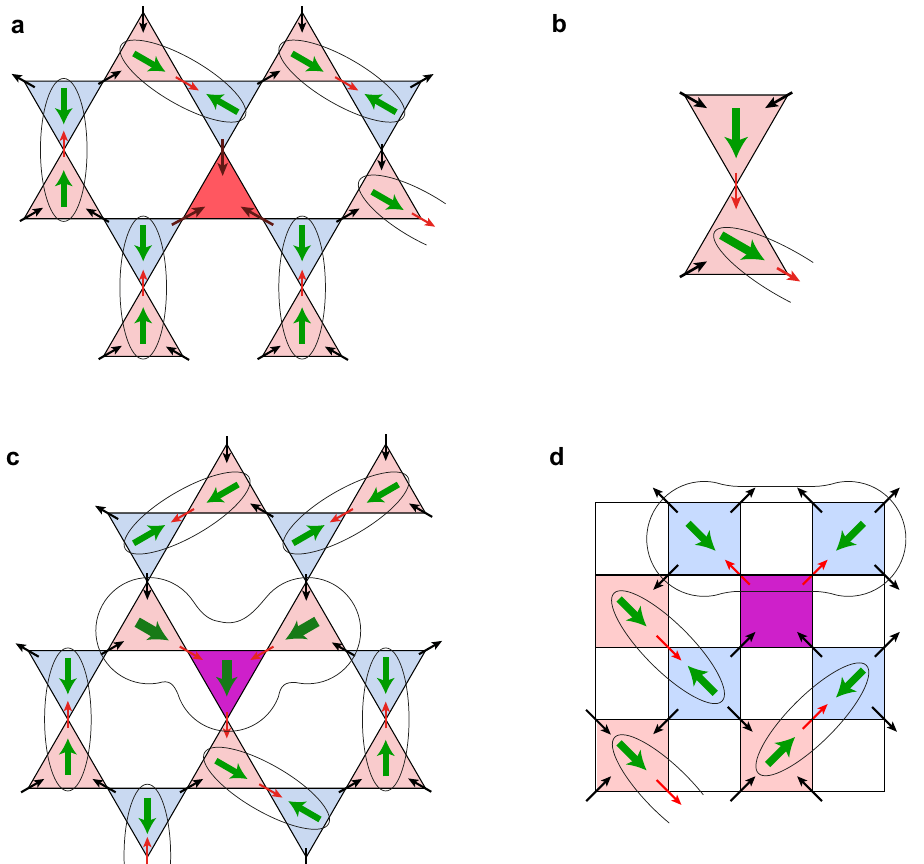
Fig. 3 Dipole structure at defects and monopole textures in kagome moment fragmentation state. a Triangle with (3-in) state ( ‘ tri-pole ’ ). Reconnection of free spins allows to create such defect without free dipoles. b Typical situation with the monopole at the ‘ wrong ’ place, at the antimonopole sublattice, demonstrating the appearance of unpaired dipoles. Note that the common spin is the ‘ normal ’ in-spin for one triangle, but it is a ‘ special ’ out-spin for the other triangle. Consequently the dipole moment at the second, upper triangle would point to this ‘ special ’ spin and would be de fi nitely unpaired. c Monopole in place of an antimonopole (magenta triangle). One sees that it inevitably leads to the creation of three unpaired dipoles: on the defect triangle itself and on two (out of three) of its neighbours. d The appearance of (two) unpaired dipoles next to (2-in)--(2-out) tetrahedron (magenta) in pyrochlore with moment fragmentation.